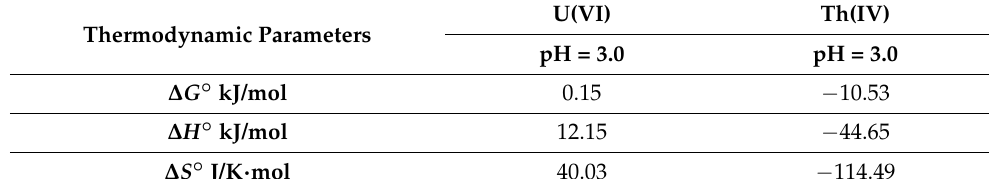
Table 5. ∆ G ◦ , ∆ H ◦ , and ∆ S ◦ of U(VI) and Th(IV) adsorption onto CCsMFO nanocomposite at 25 ◦ C. Thermodynamic Parameters